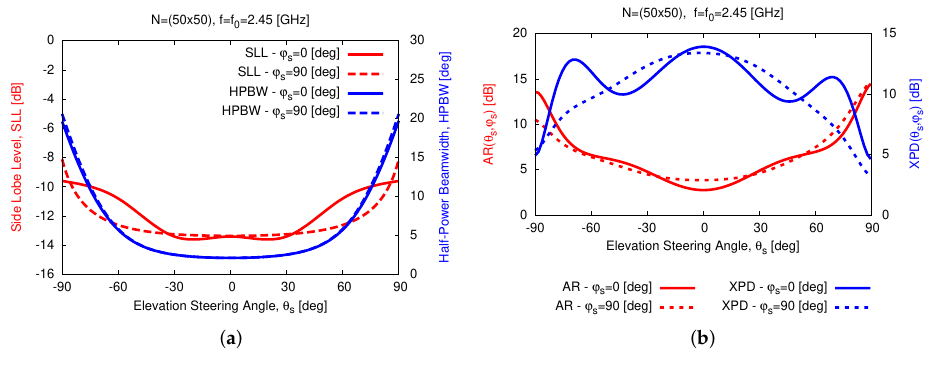
Figure 13. Numerical Assessment ( [ f min , f max ] = [ 2.3, 2.6 ] [GHz], f = f 0 = 2.45 [GHz]— N = ( 50 × 50 ) ) —Plot of the array ( a ) SLL / HPBW and ( b ) AR / XPD when scanning the beam towards θ s ∈ [ − 90, 90 ] [deg] and ϕ s = 0 [deg] or ϕ s = 90 [deg],